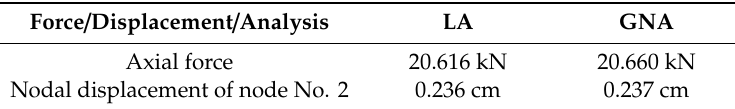
Table 1. Values of axial force and nodal displacement.